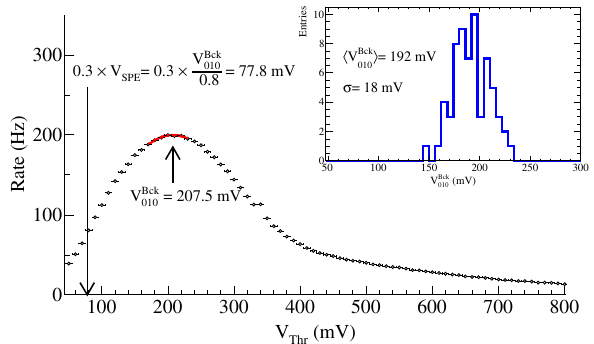
Fig. 2 Background rate, based on a ‘010’ pattern (see text) for an indi- vidual scintillator counter as a function of the threshold voltage of the correspondingdiscriminatorchannel:inthisexamplethemaximumrate is attained for a threshold 207.5mV. This value, V Bck fitting the data (red line) and corresponds to 80% of the mean V SPE . The appointed threshold for data acquisition is 0 . 3 × V SPE is also indi- cated. The inset histogram shows the distribution of V Bck discriminator channels sharing the same front-end